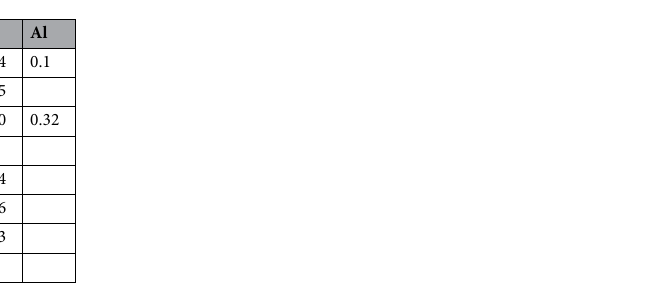
Table 3. Mineral content in tamarind seed pectin (weight